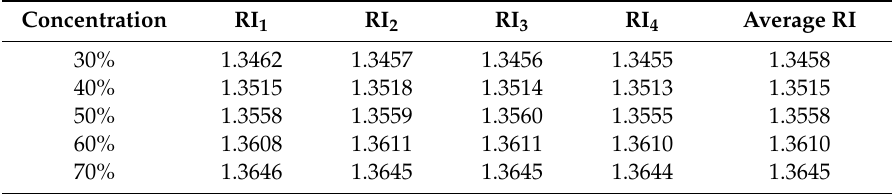
Table 2. The measured refractive index of ethanol solution with different concentrations.